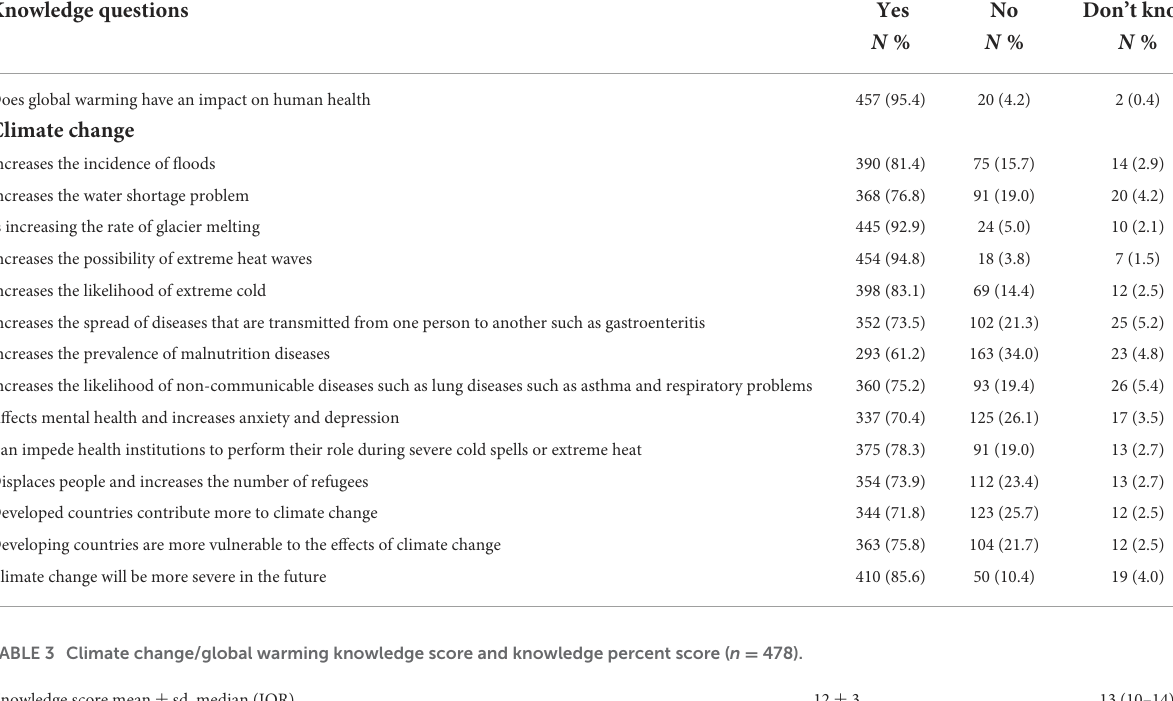
TABLE 2 Percent distribution of study participants by climate change/global warming knowledge.